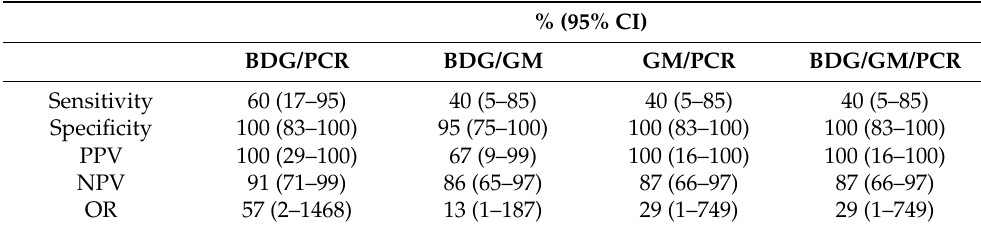
Table 4. Clinical performance of different assay combinations in probable IA and possible IFD cases if both/all biomarkers had to be positive. PPV and NPV, positive and negative predictive value, respectively; OR, odds ratio; CI, confidential